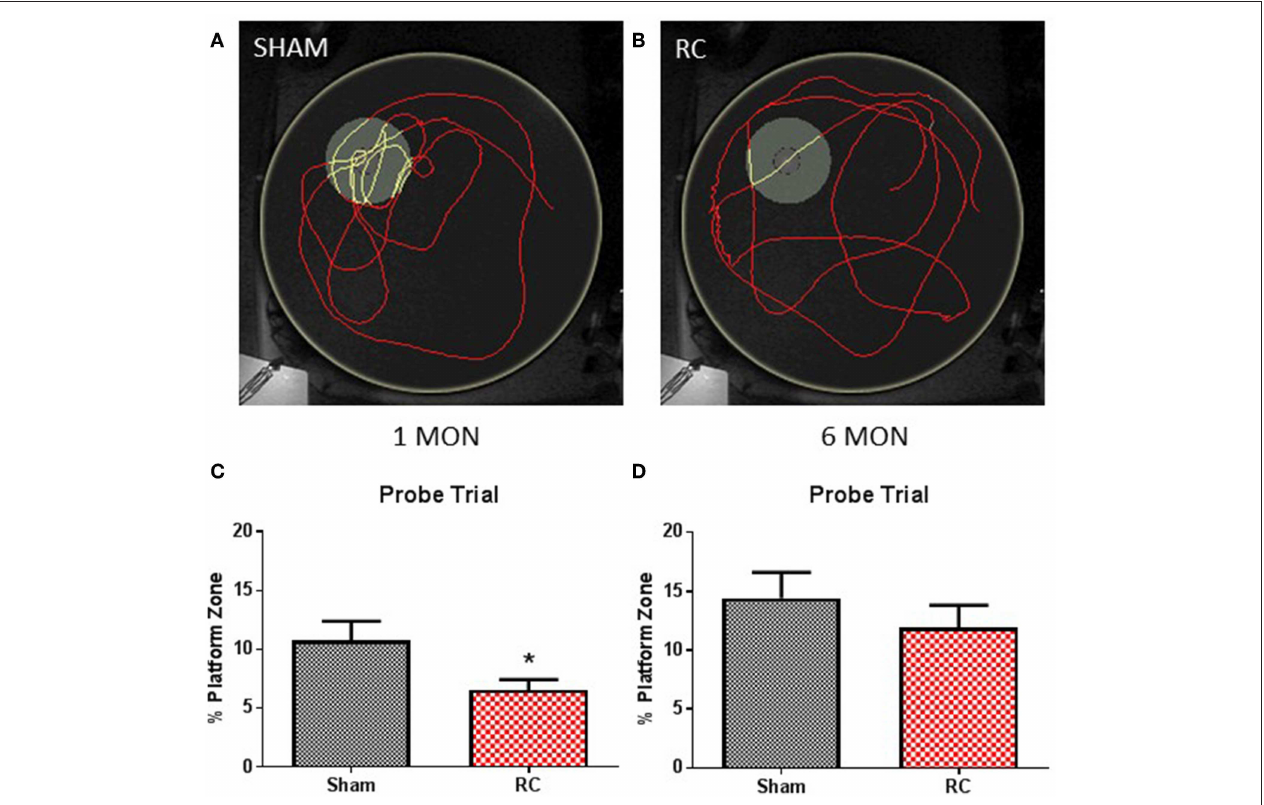
FIGURE 3 | Memory retention task. Trace within the MWM tank (yellow circle) represents swimming to search for the missing platform during the probe trial (yellow trace—platform; red trace—outside of platform) for a sham (A) or a repeated concussed rat (B) . At 1 month post-injury (C) , rats sustained repeated concussive impacts (RC) spent significantly less time in the platform zone searching for the missing platform during the probe trial in the memory retention task (group n = 12; * p < 0.05). At 6 months post-injury (D) , no differences were detected between the concussed rats (RC) and sham controls (group n =